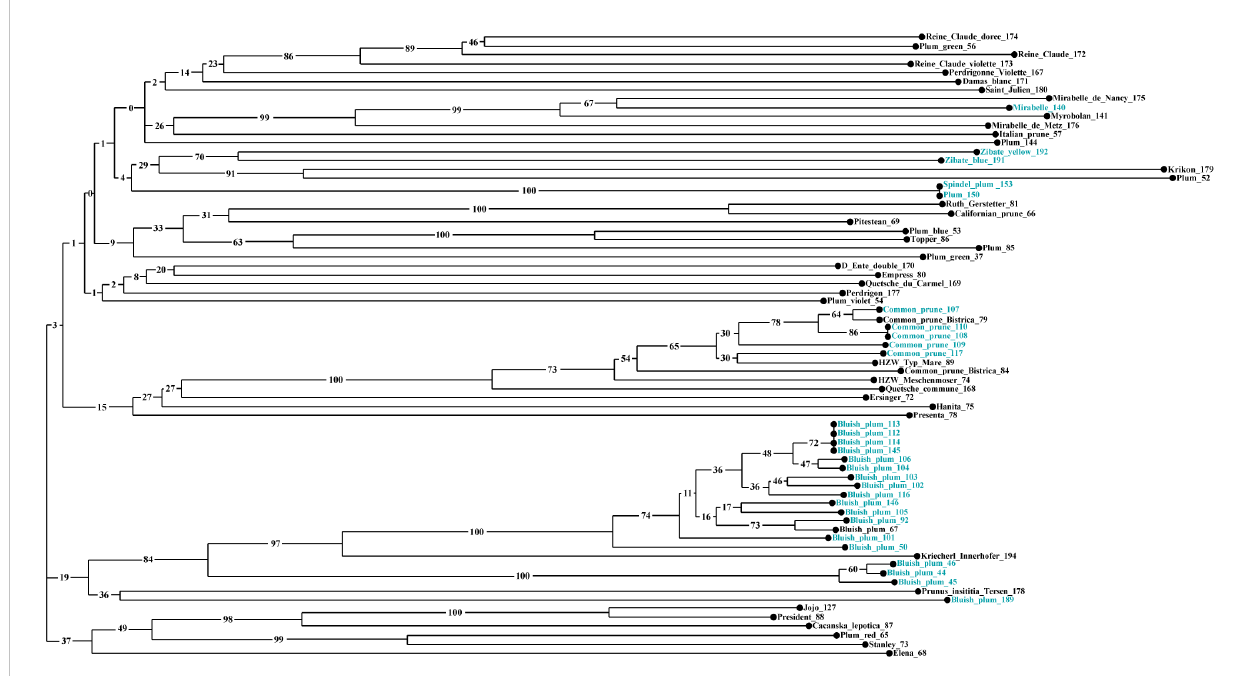
FIGURE 6 Neighbor-Joining tree based on the dissimilarity matrix calculated from the data set of 11 SSRs for 71 P . domestica accessions using the Sokal and Michener index. The colors of the accessions re fl ect the type of studied material: in situ material (blue) and ex situ material